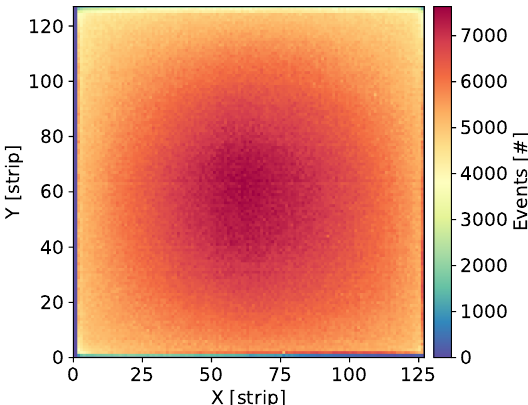
Figure 7. GEM detector B . Map of cumulative counts of reconstructed events for detector bias voltage of 3760V.